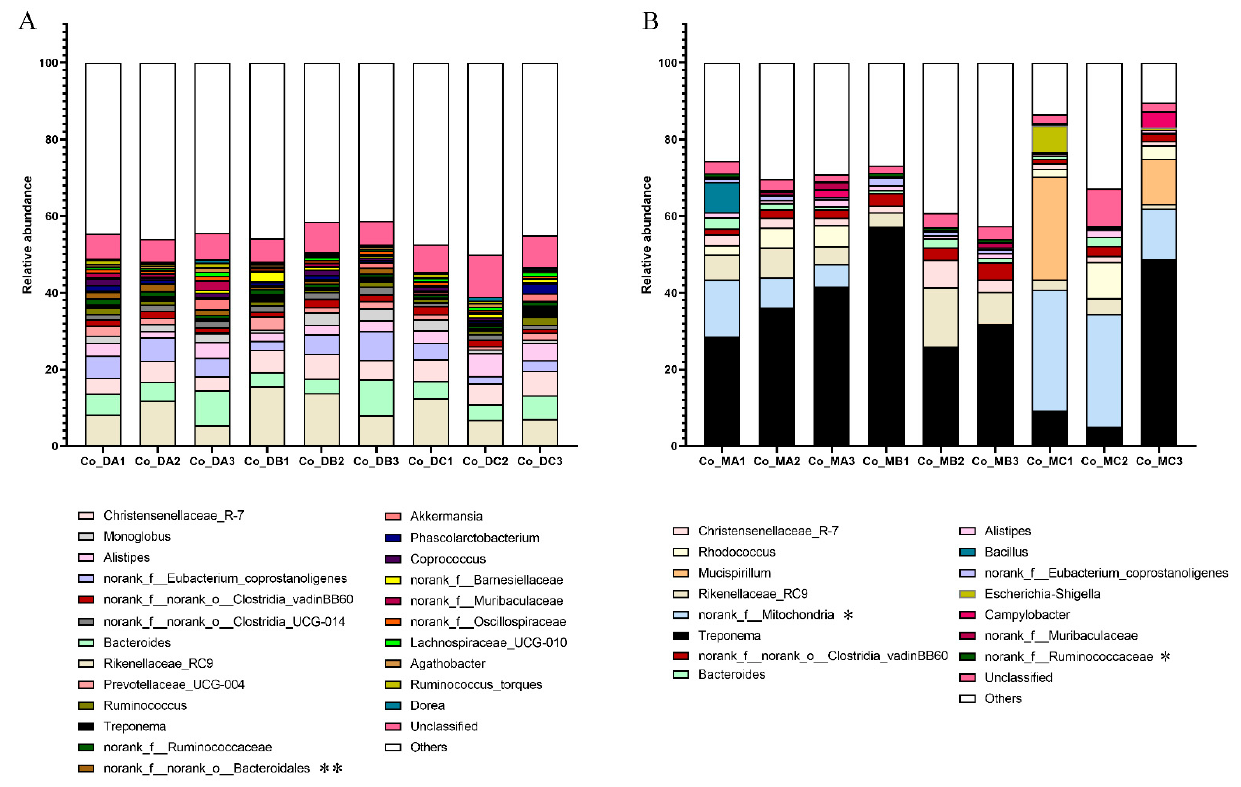
Figure 3. Effect of different nutritional levels on the abundance of bacteria in the genus level ( A ) in the colon digest and ( B ) colon mucosa. Bacteria with an abundance of less than 1% are classified as Others. “*” indicates 0.01< p <0.05. “**” indicates p < 0.01.